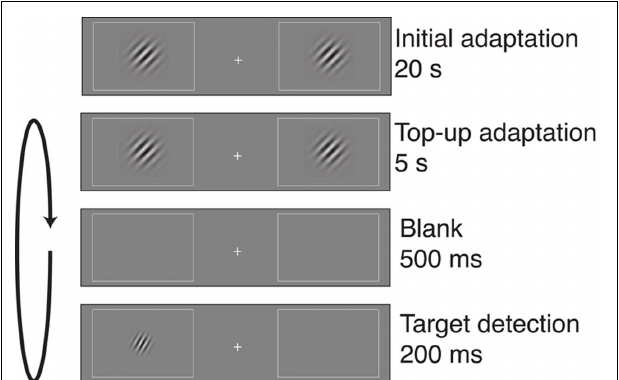
FIGURE 1 | Post-adaptation contrast detection task. Each block of trials began with a 20-s adaptation period, in which two gratings were displayed on either side of a central fixation cross. Each trial began with 5s of top-up adaptation, followed by a 500-ms interval and then presentation of a target on one side of fixation.The target could appear in one of several orientation offsets relative to the 45˚ adapter. Participants indicated whether the target appeared on the left or right of fixation, and target contrast was adjusted separately for each adapter–target orientation offset to maintain 82% correct performance for each offset. Contrast, size, and spatial frequency of the gratings have been altered in this figure to increase